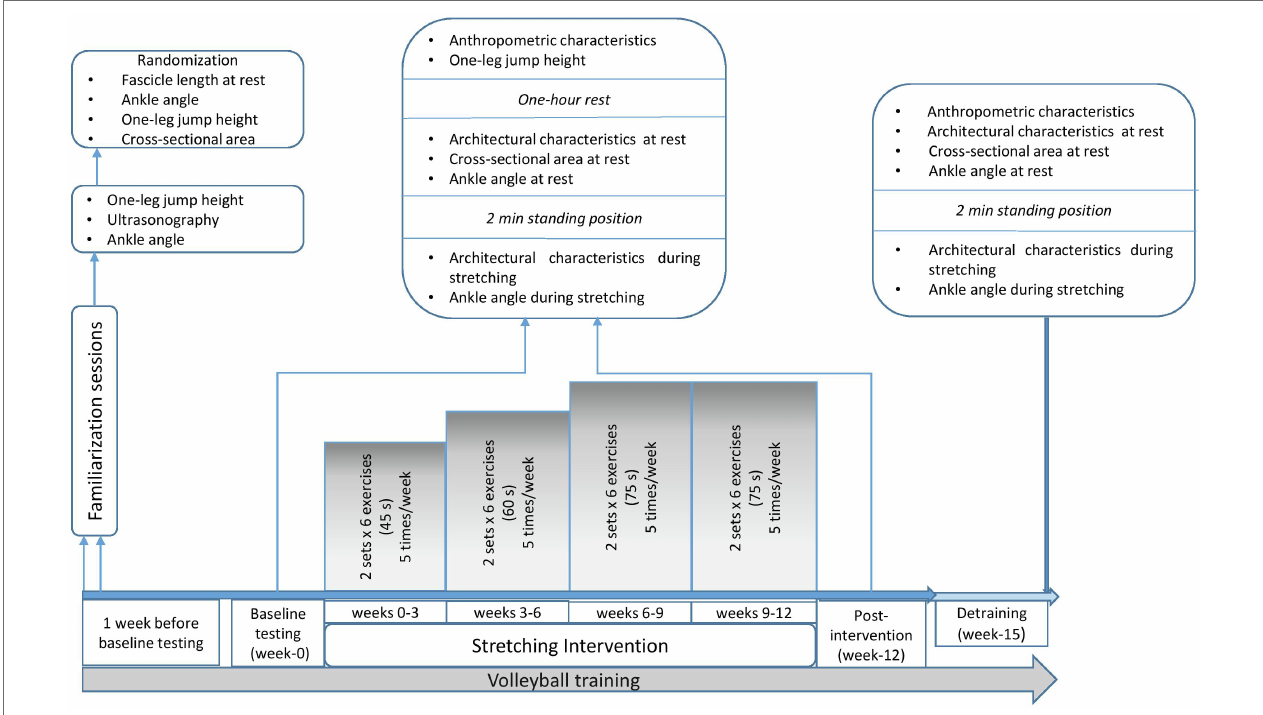
FIGURE 1 | Schematic representation of the experimental